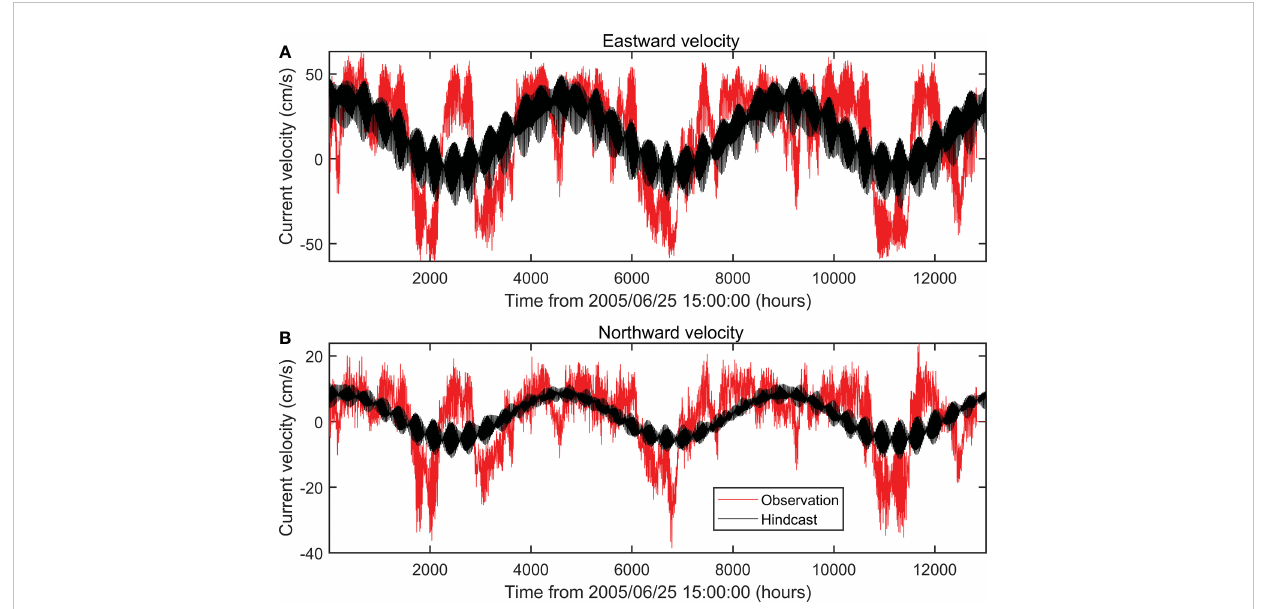
FIGURE 2 (A) Eastward current velocities (red line) and their hindcast (black line) via harmonic analysis. (B) Northward current velocities (red line) and their hindcast (black line) via harmonic analysis.